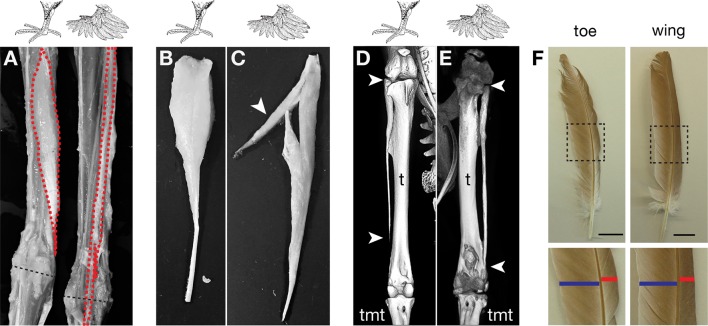
Muffed pigeons have re-patterned hindlimb musculoskeletal system and wing-like foot feathers.(A,B,C) Gross muscle morphology of scale-footed (feral) and muffed (Pomeranian pouter) left hindlimbs, dorsal view. (A) Skin and superficial muscles have been removed to reveal re-patterning of the fibularis longus (FL, red). Dashed black line, approximate position of ankle joint axis. (B,C) The FPP3 is a pinnate muscle in scale-footed pigeons (B), but a slip of fibers fuses with the adjacent FL in muffed pigeons (arrowhead in C). (D,E) X-ray computed tomography images of scale-footed (feral, right leg) and muffed (English trumpeter, left leg) hindlimbs. Arrowheads mark the proximal and distal ends of the fibula. The wild-type pigeon fibula (D) is short and splint-like. In the muffed bird (E), the fibula extends from the knee to the ankle. We observed distal elongation of the fibula in another muffed breed (fairy swallow) but the fibula did not completely extend to the ankle (not shown). t, tibia; tmt, tarsometatarsus. (F) Toe and wing (flight) feathers of a muffed pigeon (English trumpeter), highlighting vane width asymmetries. Blue bar, inner vane; red bar, outer vane. Scale bar = 2 cm.